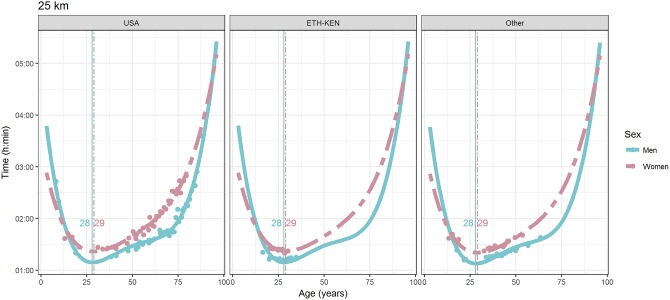
World record in 25 km by sex, age (in years), and country. Points were observations. Curves represented quartic degree polynomial regression. Vertical lines with numeric labels were the ages at peak performance.